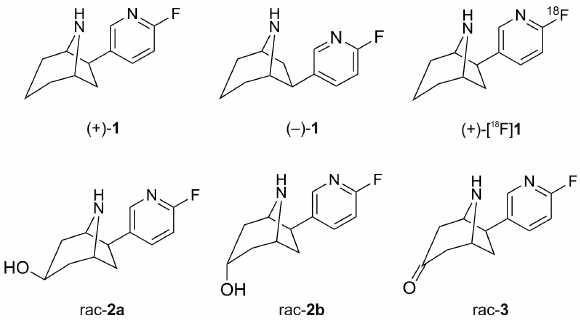
Figure 1. Chemical structures of (+)-flubatine ((+)- 1 ), ( − )-flubatine (( − )- 1 ), (+)-[ 18 F]flubatine ((+)-[ 18 F] 1 ) and reference compounds (±)- exo -3-hydroxy-flubatine ( rac - 2a ), (±)- endo -3-hydroxy-flubatine ( rac - 2b ), (±)-flubatine-3-one ( rac - 3 ).